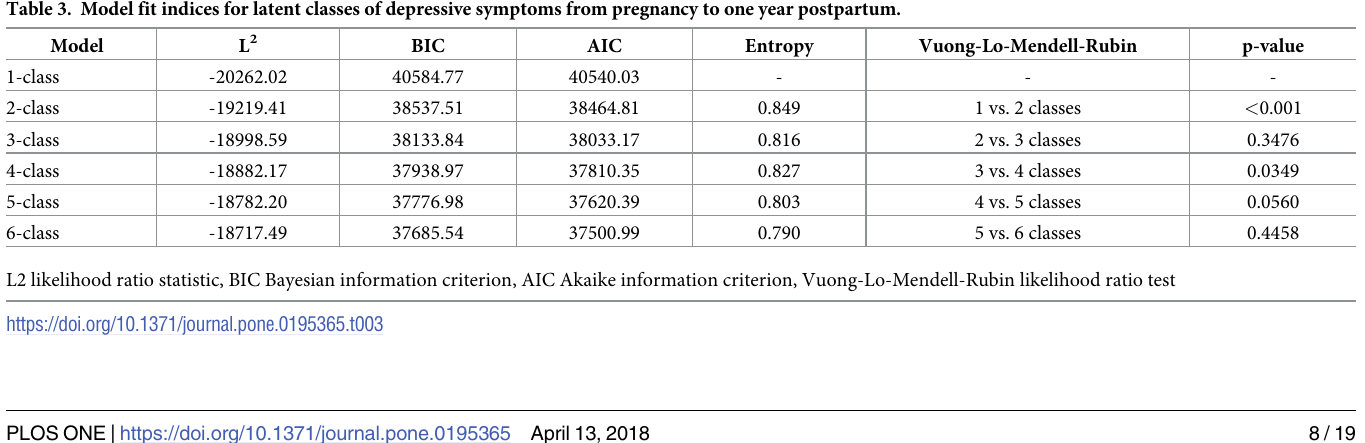
pregnancy to one year postpartum (n = 1283, 64.7%). The second trajectory, with a peak in the “early postpartum depressive symptoms” (n = 216, 10.9%). The third trajectory consisted of